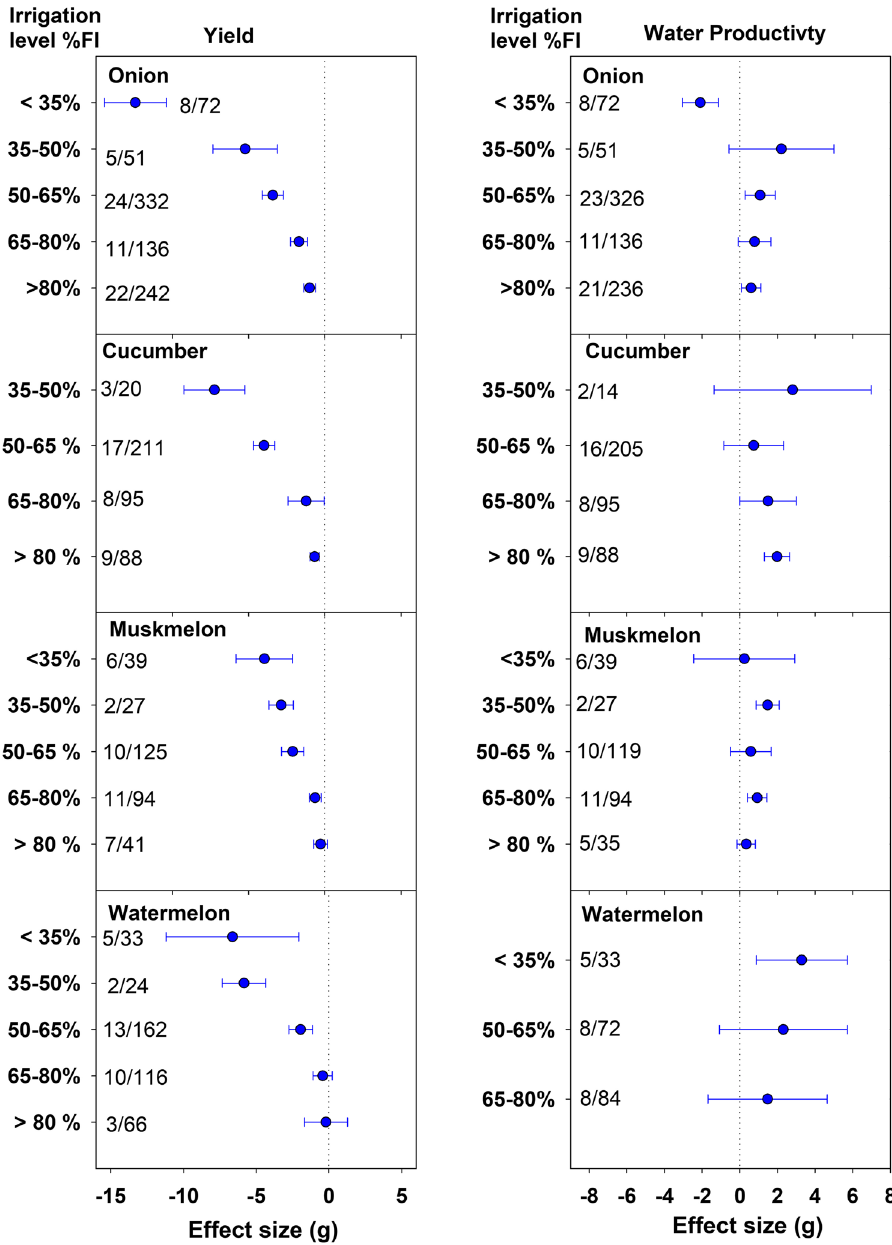
Figure 2. Effect of deficit irrigation levels on yield and water productivity (WP) of onion, cucumber, muskmelon and watermelon. The dotted line (effect size = 0) represents full irrigation. Effect size > 0 indicates increase and effect size < 0 indicates reduction in yield and WP for deficit irrigation level relative to full irrigation (FI). Non-overlapping confidence intervals (horizontal bars) indicate significant differences. Numbers on right side of Y-axis represent number of